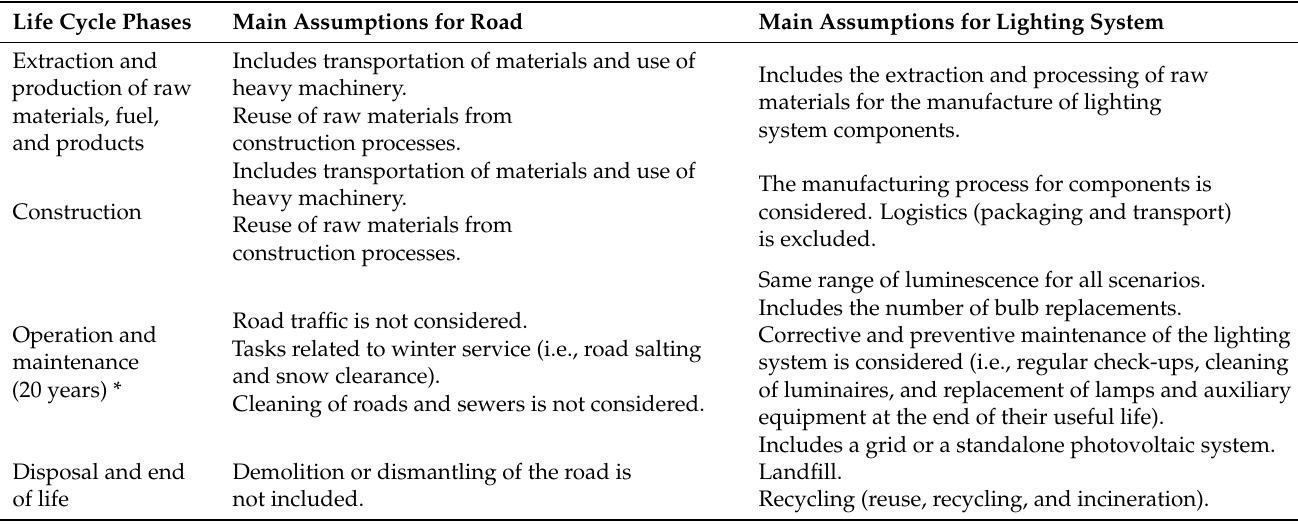
Figure 3. System boundaries. Table 4. Main assumptions for